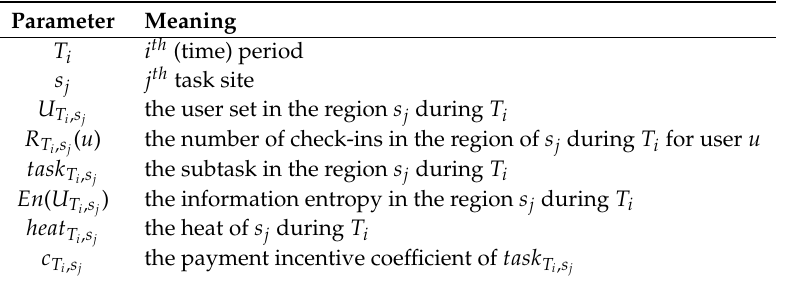
Table 1. Parameters and their